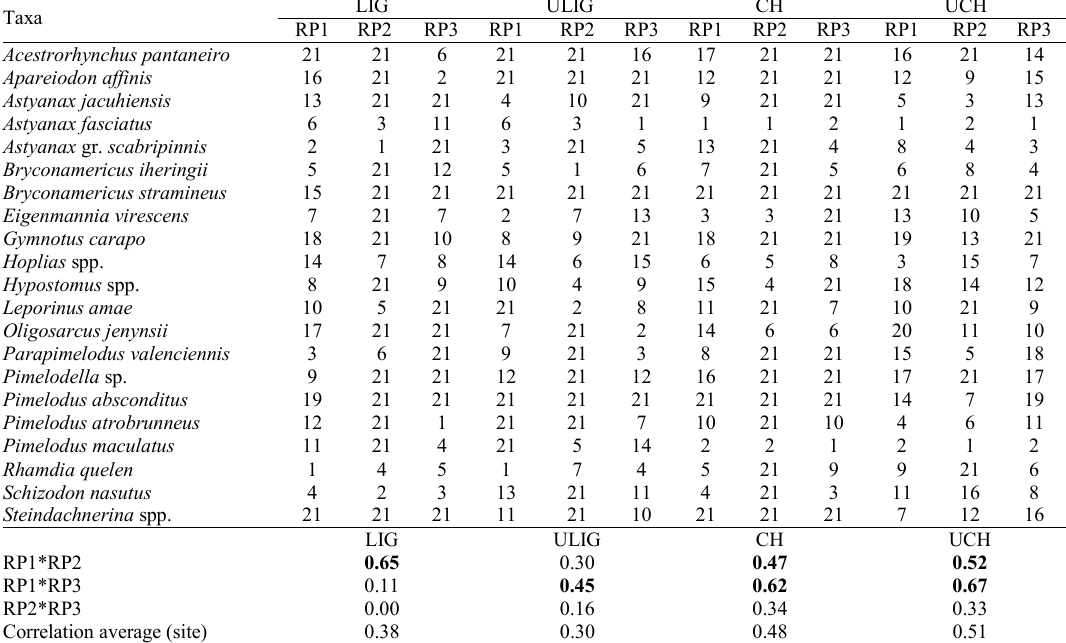
Table 3 . Abundance ranking for each reproductive period, by sampling site and average ± standard error (SE) of larvae density from the 21 most frequent species. Correlation matrix between reproductive periods among most abundant species. Numbers in bold represent